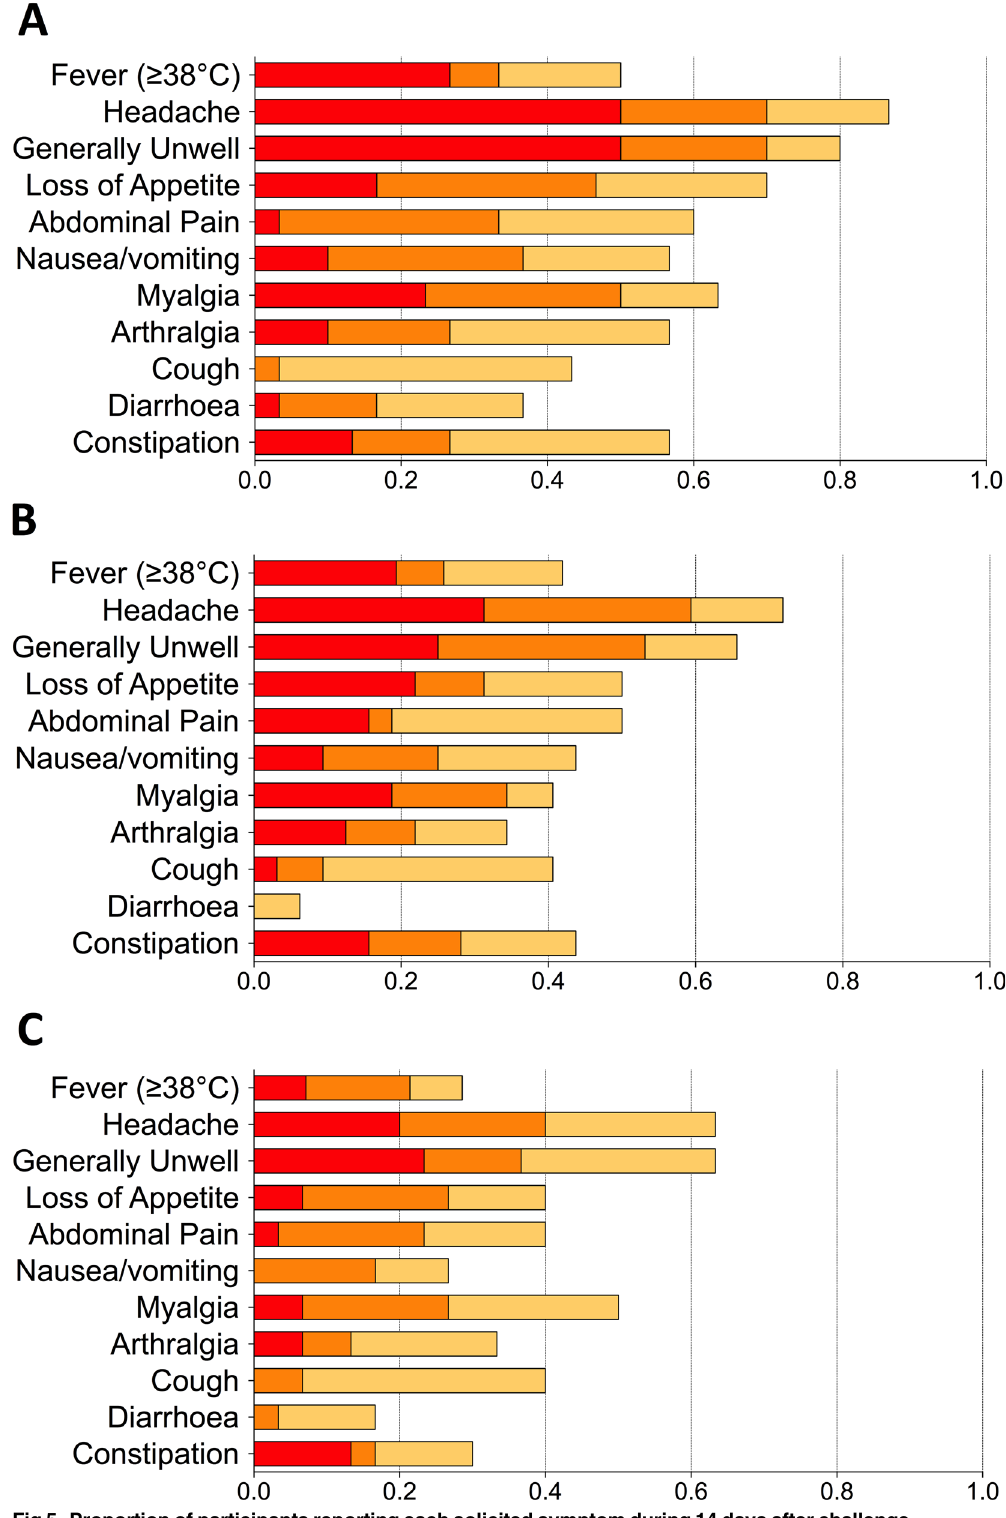
Fig 5. Proportion of participants reporting each solicited symptom during 14 days after challenge according to vaccine group allocation. (A) Placebo, (B) M01ZH09, and (C) Ty21a vaccine recipient groups. Maximum severity score per participant for each symptom was used and graded according to criteria detailed in